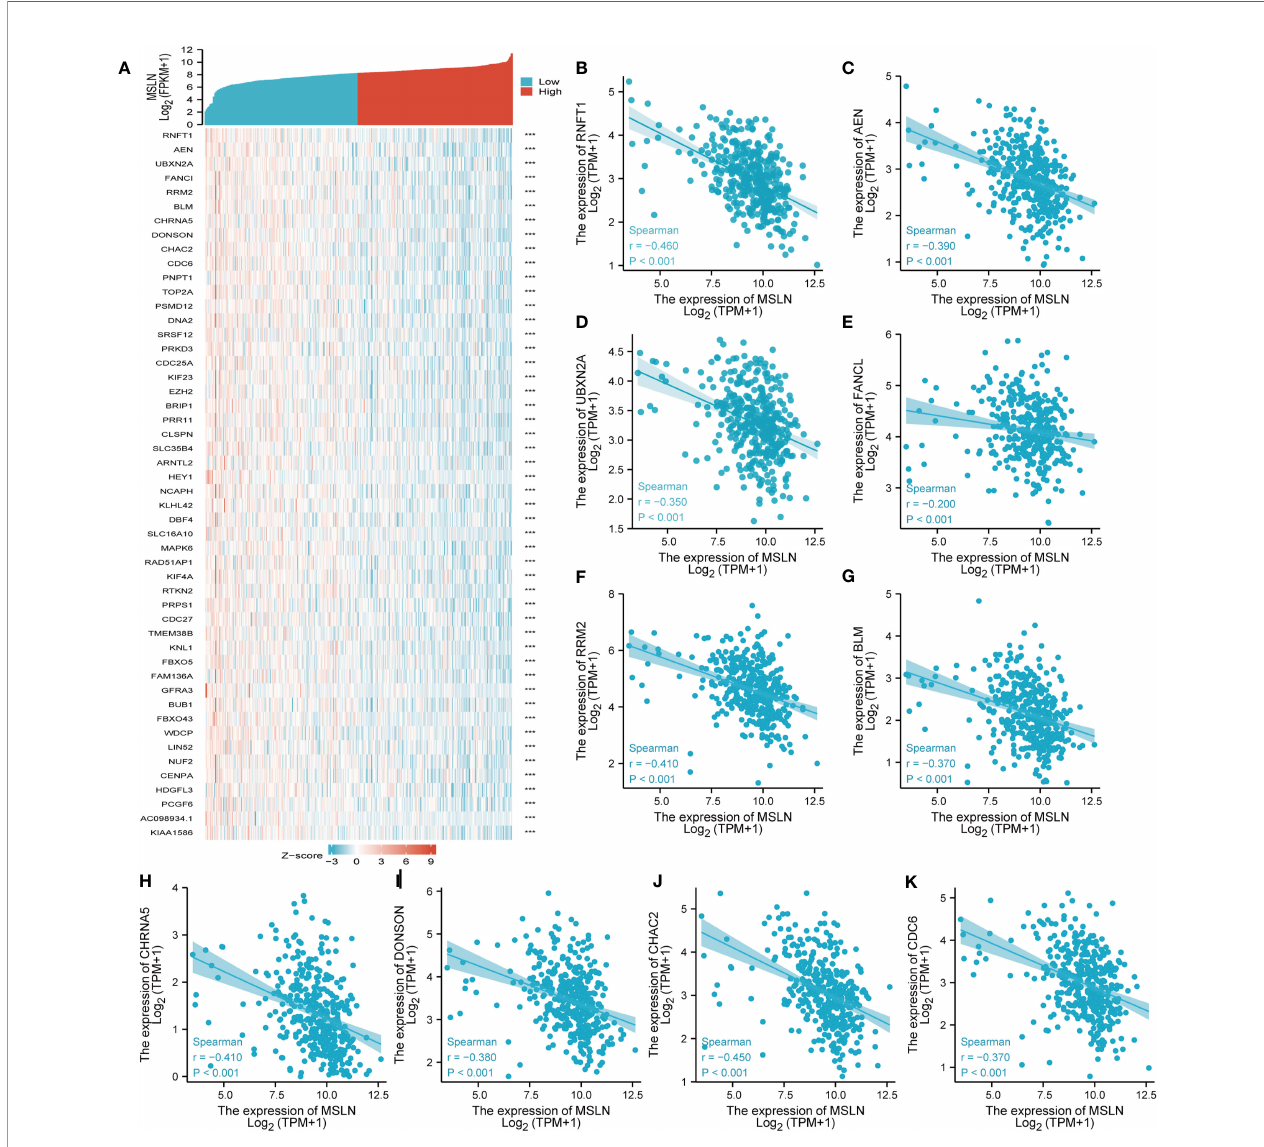
FIGURE 5 | Top 50 genes negatively correlated with MSLN expression in ovarian cancer. (A) The gene co-expression heatmap of the top 50 genes negatively correlated with MSLN in ovarian cancer. (B – K) Correlation analysis of the top 10 genes and MALN in the heatmap. ***, p